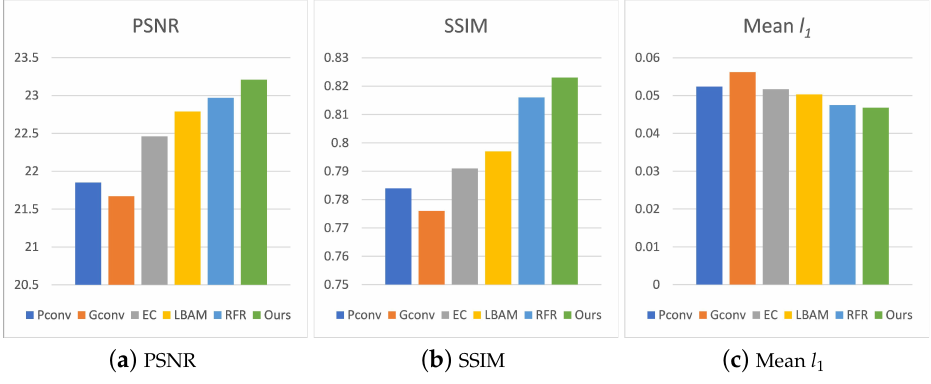
Figure 7. Quantitative comparison of CelebA, the mask ratio is between 0.5 and 0.6. Table 1. Numerical comparisons on the Place2 dataset. ↑ indicates higher is better while ↓ indicates lower is